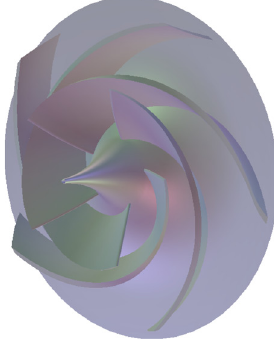
Figure 1: Visualization 3D of NS32 impeller. Table 1: Geometrical parameters of the pump N S =